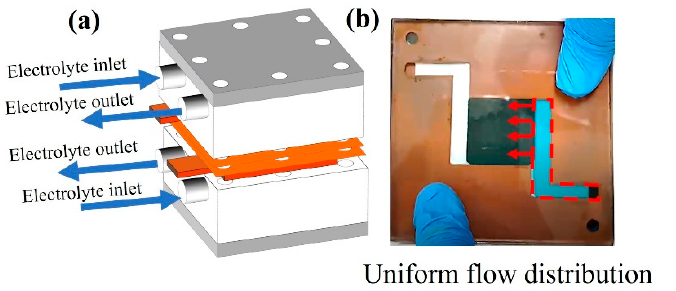
Figure 11. ( a ) Horizontal electrolyte feeding channel and ( b ) a snapshot of liquid flow into the flow frame and electrode layers. Figure 12. The schematic of electrolyte diffusing into electrode layers in a horizontal flow battery.